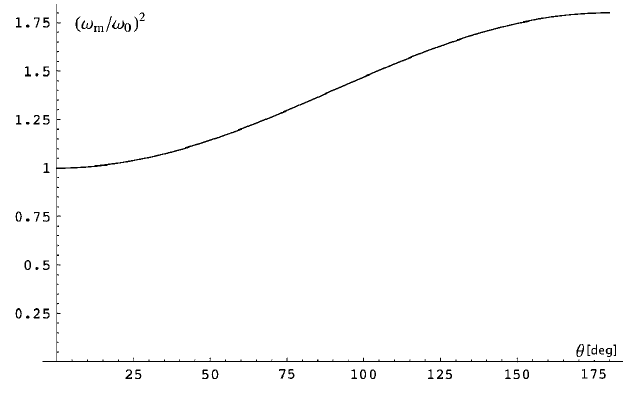
Þ 2 as a function of (cid:3) ½ (cid:5) (cid:7) ¼ 180 (cid:5) (cid:6) m=N for FIG. 11. ð ! m =! 0 the (very large) coupling constant K ¼ 0 : 2 .